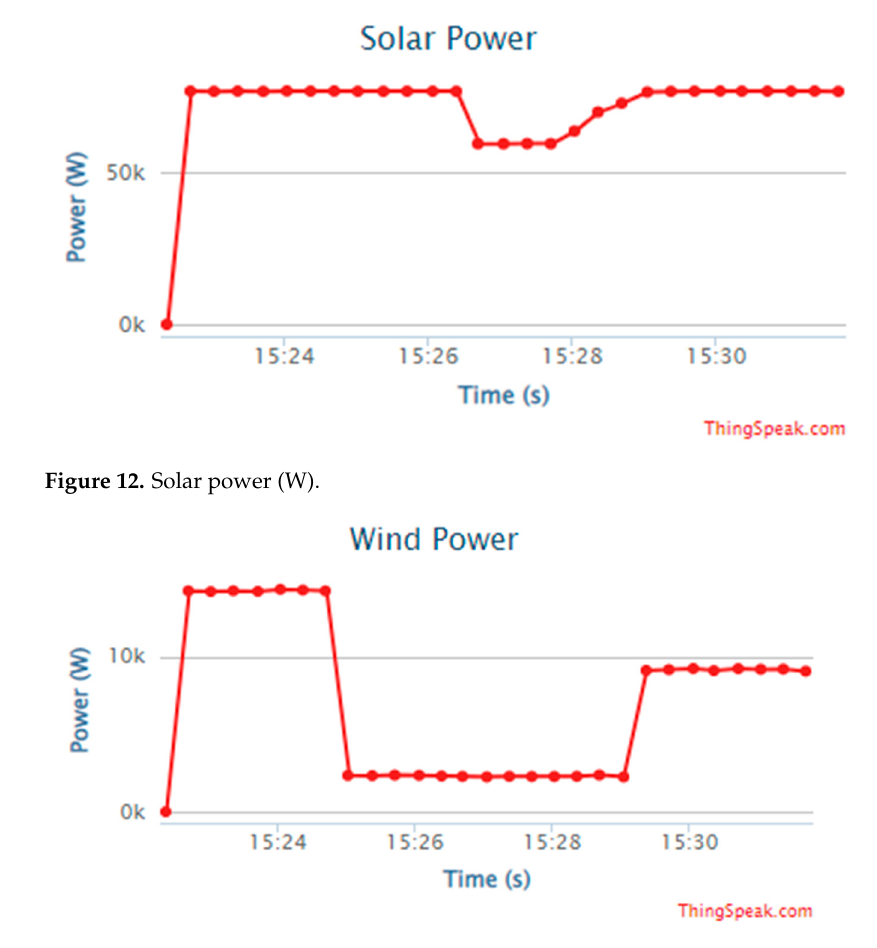
Figure 13. Wind power (W).